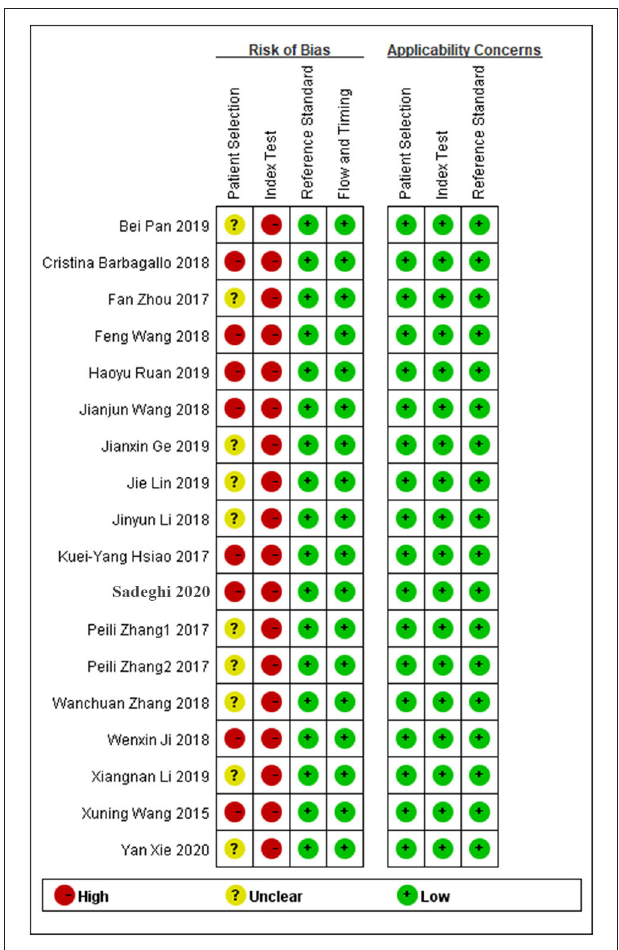
FIGURE 2 | Methodological quality